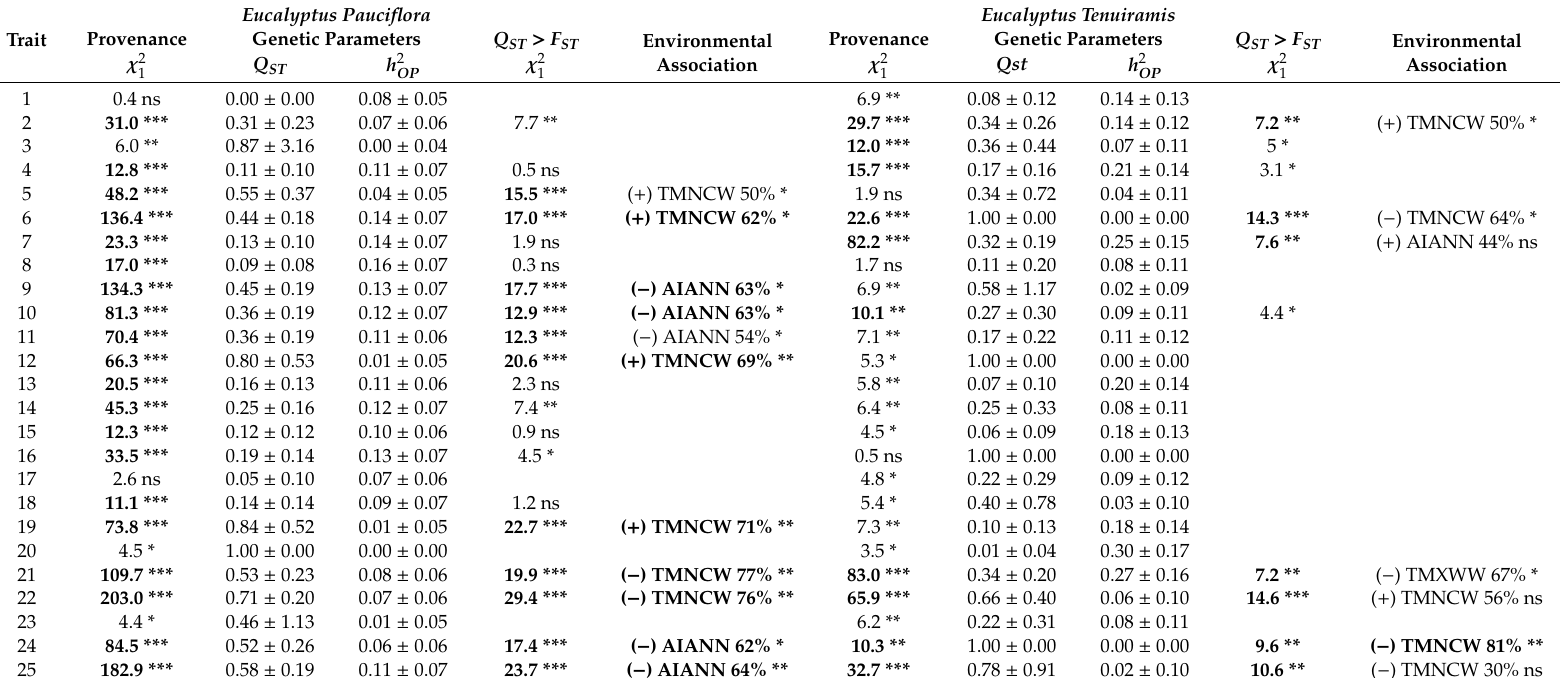
Table 3. Genetic parameters for the 25 traits derived from individual tree LiDAR point clouds. Shown for each species is the provenance one-tailed Chi-squared statistic and its significance from zero, the quantitative inbreeding coe ffi cient ( Q ST ± standard errors) and narrow-sense heritability ( h 2 Q ST > F ST one-tail Chi-squared statistic and its significance. Environmental association modelling of provenance least-square means for traits signalling divergent selection ( Q ST > F ST ) as a function of altitude or climate showing the sign of the relationship, the best environmental predictor, the coe ffi cient of determination expressed as a percentage, and the significance of the association. In all cases, the best environmental association models had a linear slope except for trait 24 that had a quadratic slope. Values in bold correspond to traits significant after a Bonferroni